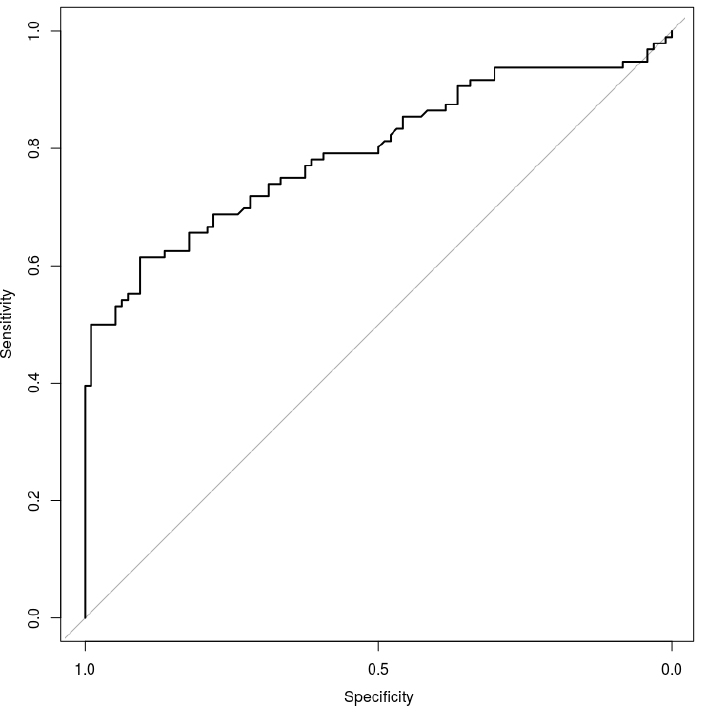
Figure 2. Receiver operating characteristic (ROC) curve obtained considering the random forest model initialised with default parameters.